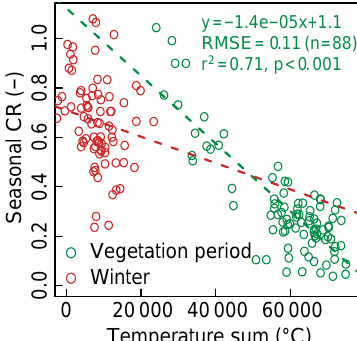
Figure 6. Hourly summer and winter temperature sums, calculated for the dormant period and the period of vegetation, plotted against seasonal summer (green) and winter (red) runoff coefficients for all sites ( n = 22) and years ( n = 4). The dotted lines are linear regres- sions. Statistical information on the summer model is plotted in green. During winter we did not find a significant statistical rela- tion ( r 2 = 0 . 04, p = 0 . 062). Statistical properties of all dDMC are summarized in Table